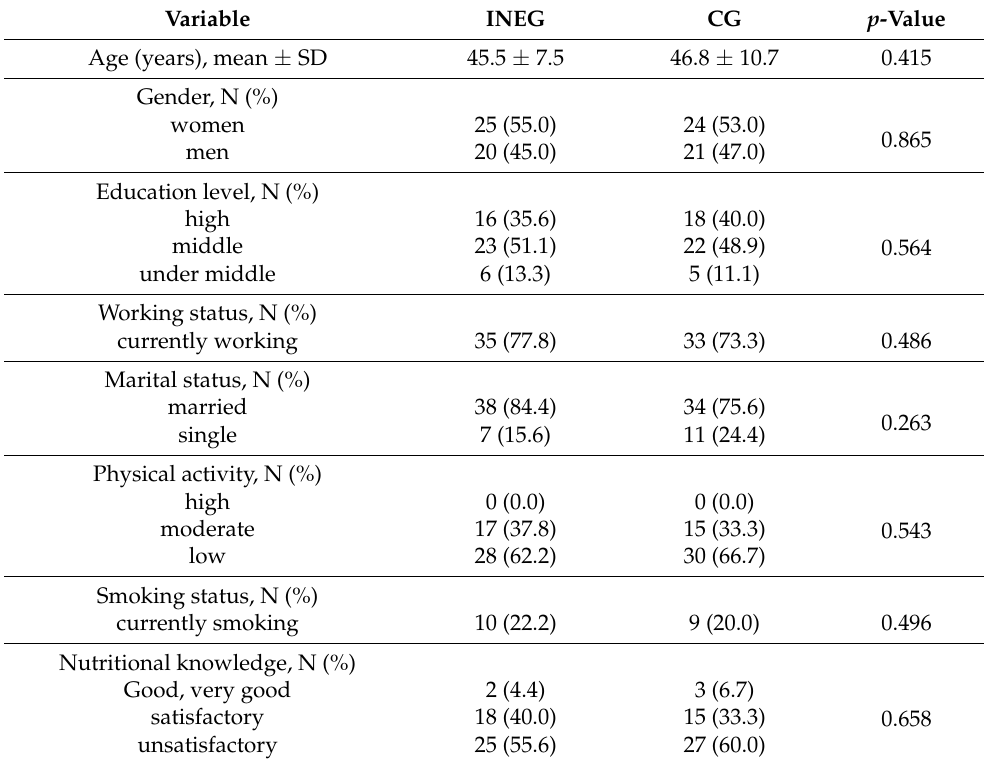
Table 2. Baseline characteristics of the